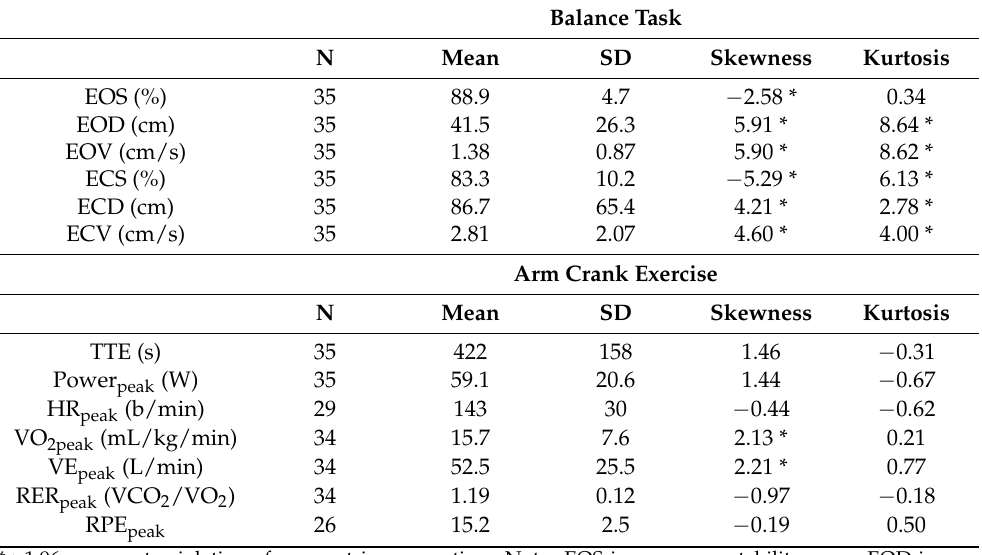
Table 2. Means, standard deviations, and variable statistics for normal